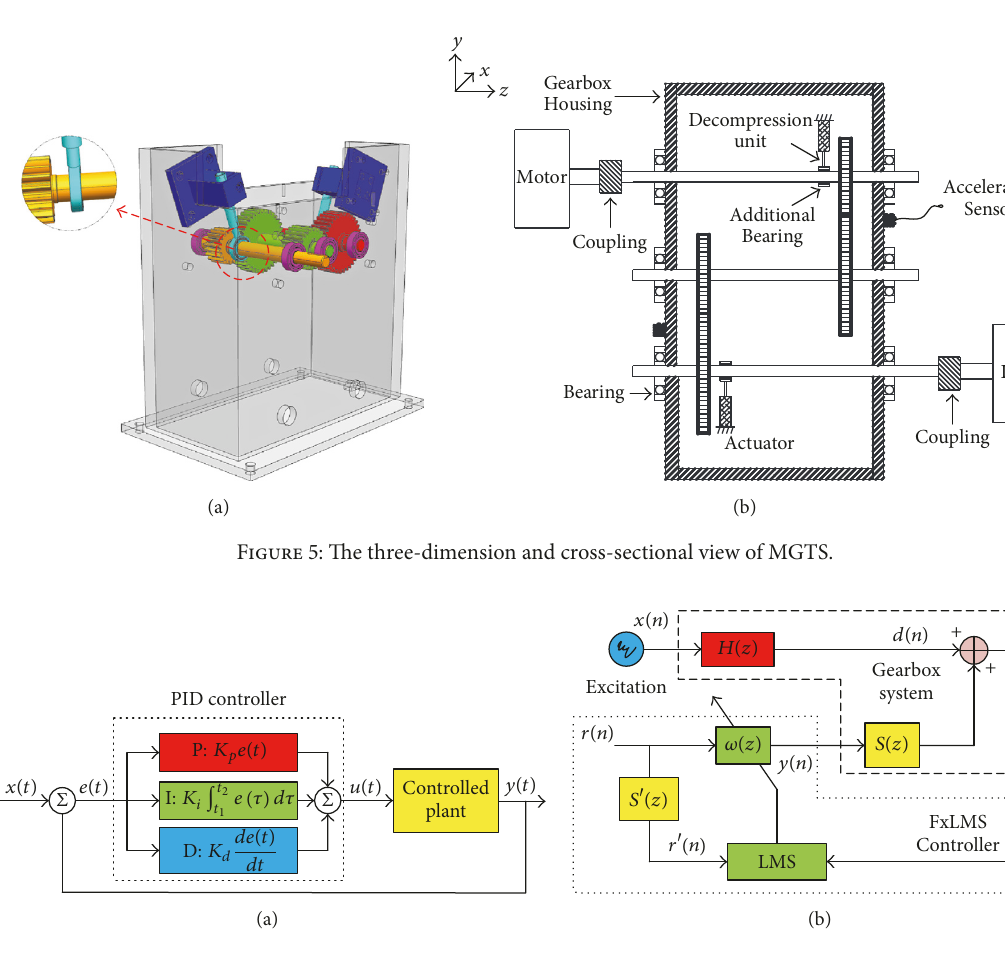
Figure 6: The schematic diagram of PID control algorithm and FxLMS